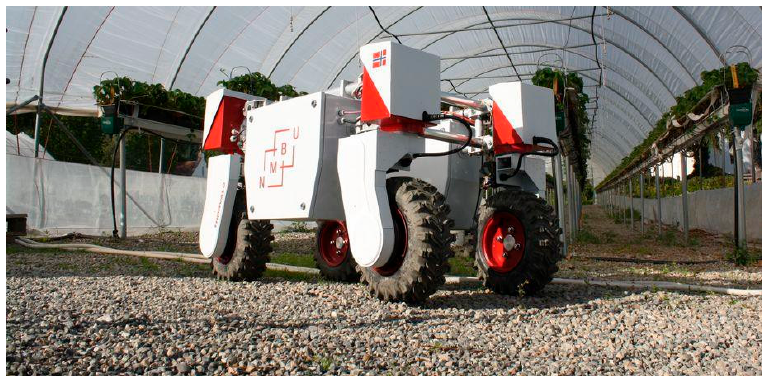
Figure 1. Thorvald II agricultural robotic system.